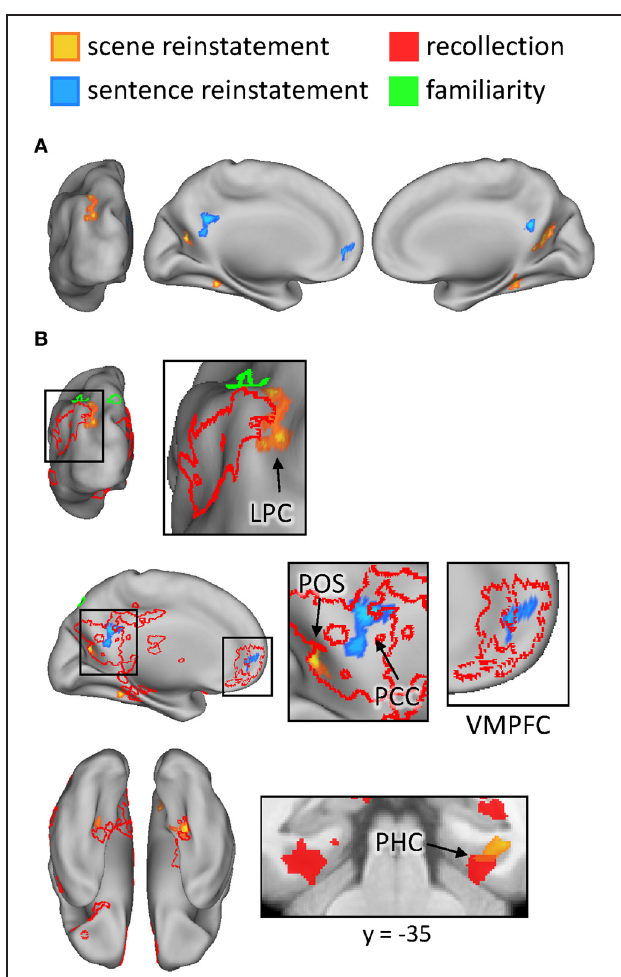
FIGURE 6 | (A) Regions exhibiting content-sensitive reinstatement effects. Warm colors indicate reinstatement-related activity for the scene condition (scene > sentence at study, inclusively masked with R scene > R sentence at test); cool colors indicate reinstatement-related activity for the sentence condition (sentence > scene at study, inclusively masked with R sentence > R scene at test). (B) The content-sensitive reinstatement effects are displayed alongside the neural correlates of recollection (red outline and solid) and familiarity (green outline and solid). Arrows point to notable overlapping and adjacent effects that are described further in the text. LPC (lateral parietal cortex), POS (parieto-occipital sulcus), PCC (posterior cingulate cortex), VMPFC (ventromedial prefrontal cortex), PHC (parahippocampal